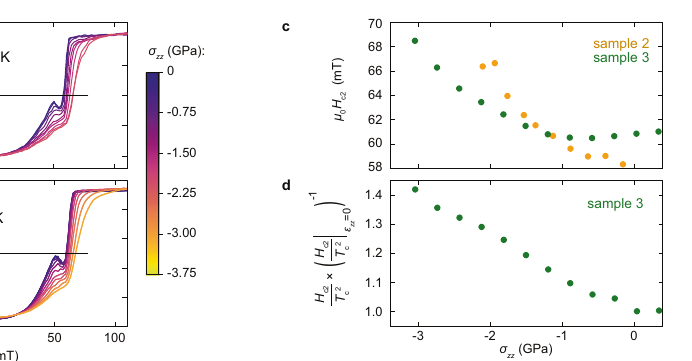
Fig. 4 | H c2 under c-axis stress. a , b Susceptibility versus applied fi eld ∥ c for samples 2 and 3, at fi xed temperatures of 300 mK and 310 mK. For sample 3, the raw data are plotted. For sample 2, the signal magnitude shifted from run to run, probably due to slipping of the coils against the sample, so data are